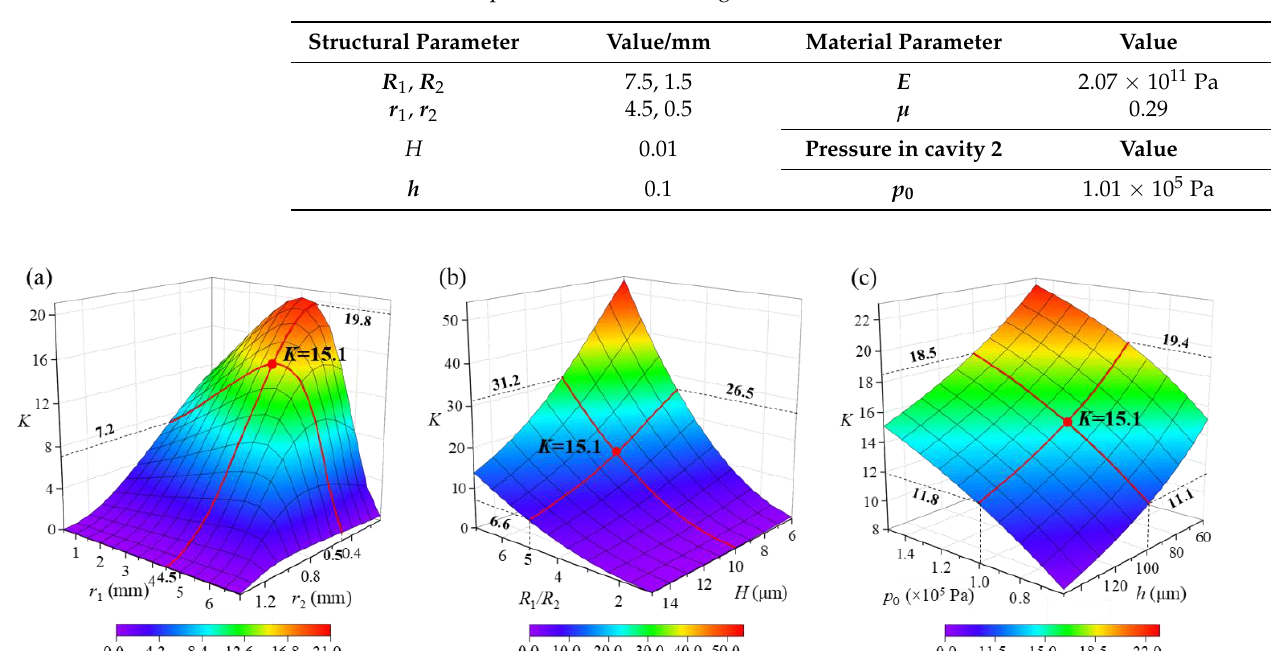
Figure 3. Simulation on ( a ) the effect of the radius r 1 and r 2 of the connecting rod on K , ( b ) the effect of the ratio of radius R 1 / R 2 and the thickness H of two diaphragms, and ( c ) the effect of the height h and the initial pressure p 0 of cavity 2 on K .